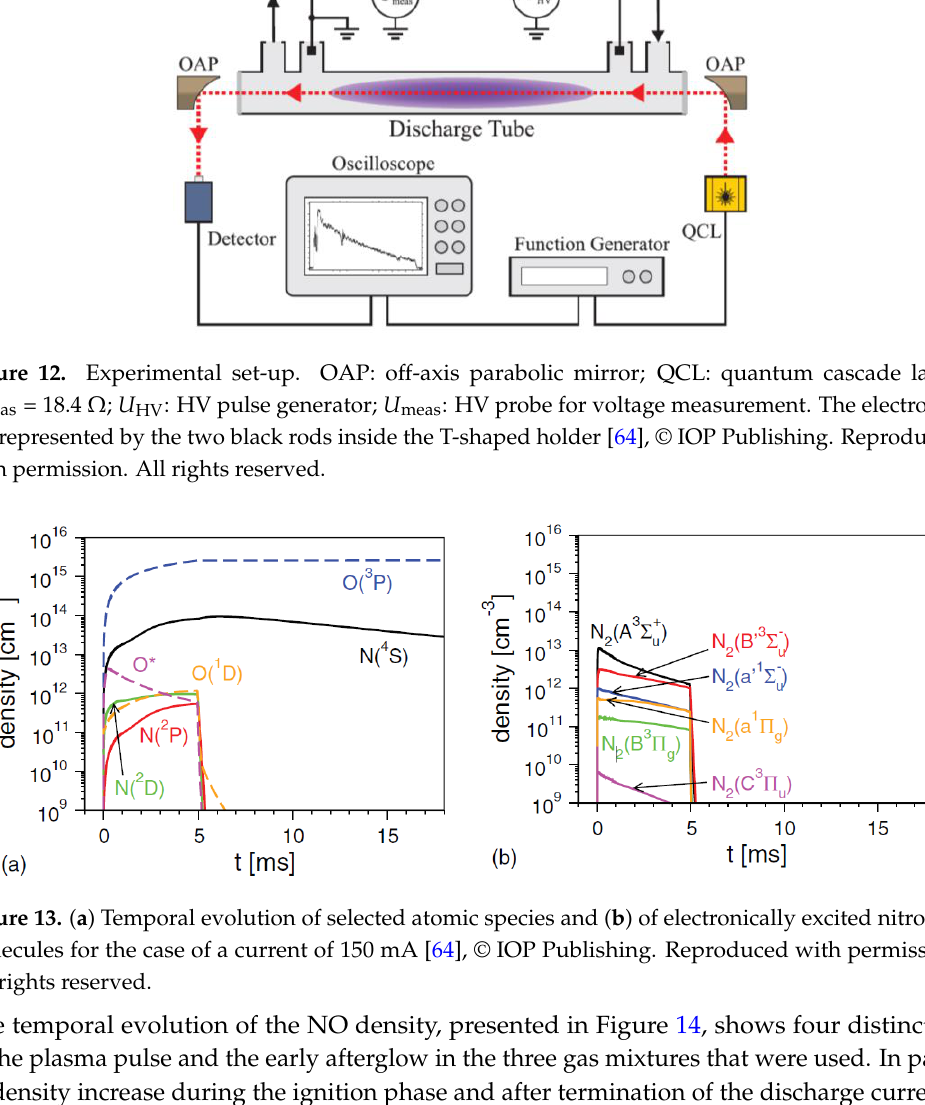
Figure 14. Temporal evolution of the measured (symbols) and calculated (full line) NO density in synthetic air for I = 150 mA. The dashed line represents the gas temperature. The dashed-dotted line is the plasma pulse [64], © IOP Publishing. Reproduced with permission. All rights reserved. After the current pulse terminates, the early afterglow phase begins (phase III). Here, the density of NO continues to increase again, and with a slightly increased rate compared to phase II. The enhancement of the NO density terminates about 2 ms after the end of the active phase. During the late afterglow (phase IV) the measured NO density remains nearly unchanged and the gas